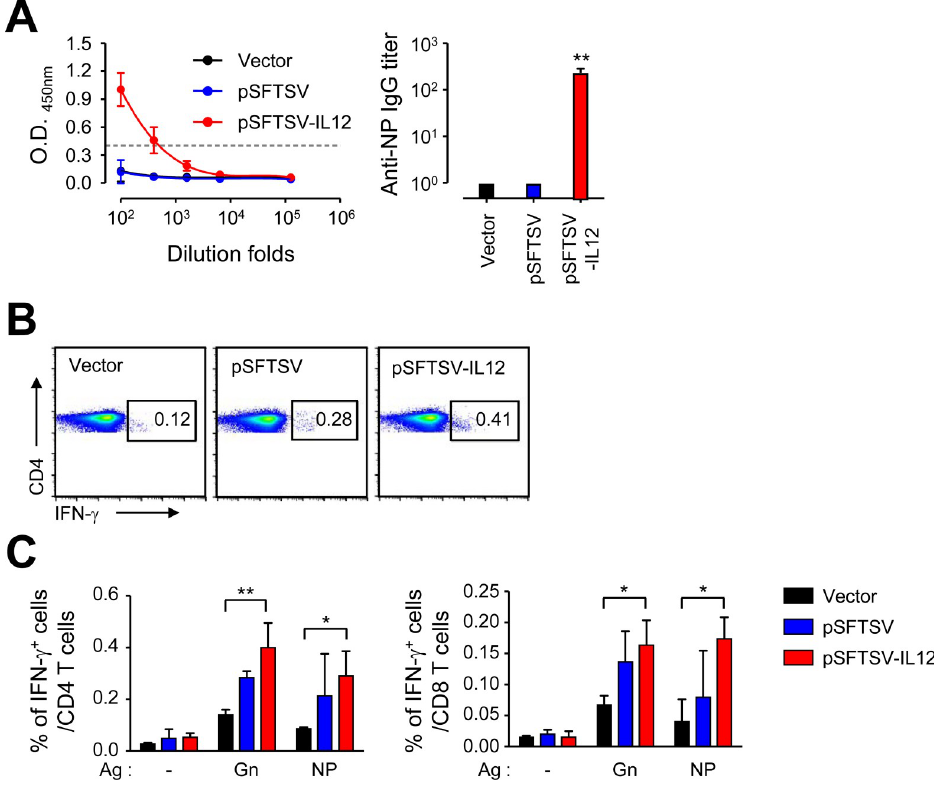
Fig 3. Generation of antigen-specific antibodies and T cell responses in IFNAR KO mice vaccinated with SFTSV DNA vaccines. (A) Anti-NP IgG response was measured by ELISA at two weeks after the third vaccination. The antibody titers of anti-NP IgG in sera of mice ( n = 3) immunized with different DNA vaccines are presented. Cut-off titers (dashed line, mean O.D. + 3 x S.D. at 1:100 diluents) was determined using sera from vector-immunized mice. Error bar: mean ± S.D. (B and C) Splenocytes were collected from mice at two weeks after the third immunization with the indicated DNA vaccines. Production of IFN- γ by CD4 + T or CD8 + T cells were analyzed by flow cytometry after stimulation with the indicated antigens. Representative flow cytometric results are presented (B) and the percentile of cytokine positive cells among CD4 + or CD8 + T cell subsets are summarized (C). Data shown as mean + S.D. from duplicate assays with three mice per group. � , p < 0.05; �� , p <